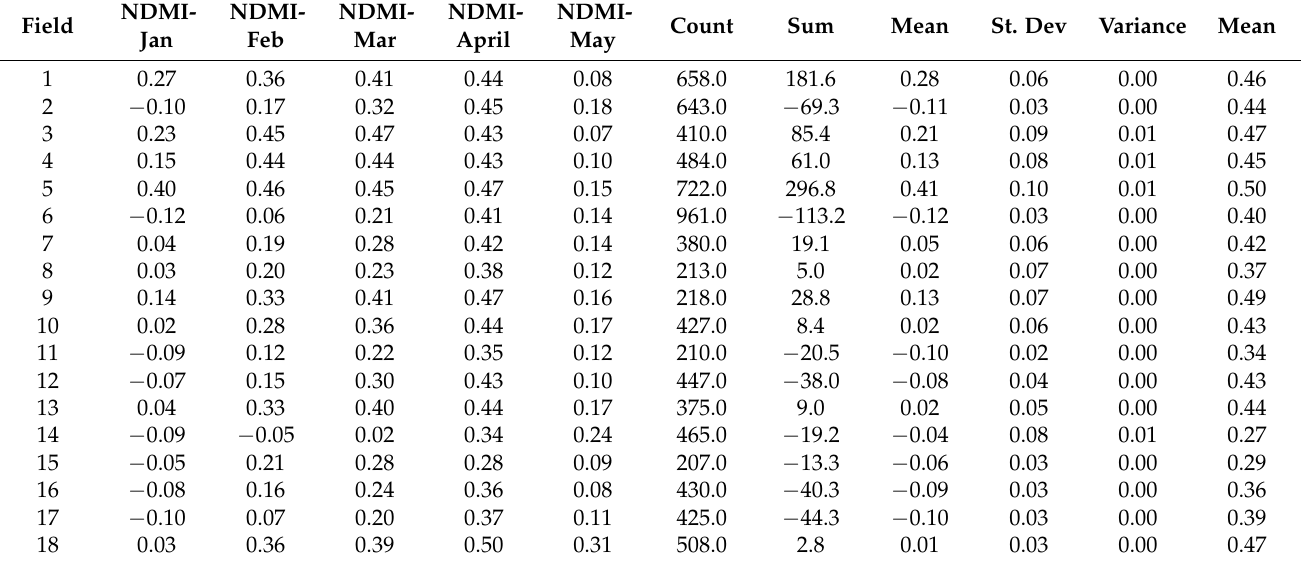
Table A3. Monthly Average NDMI in 143 Center Pivot Values Zonal